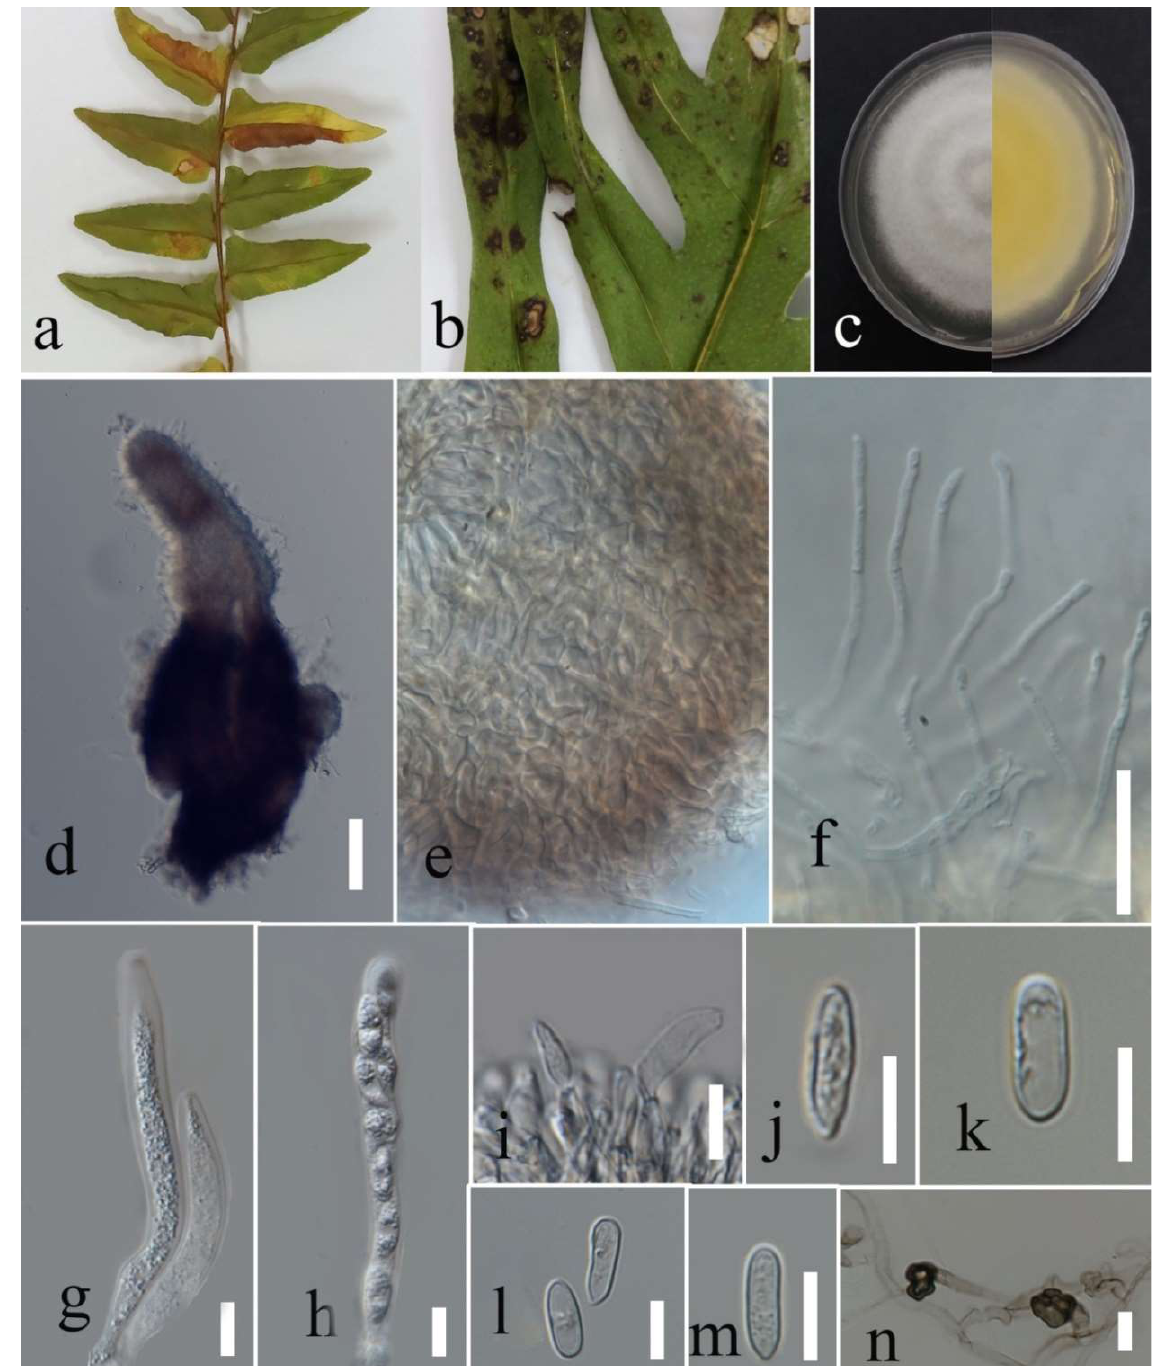
Figure 24. Morphology of Colletotrichum polypodialium ( ex-type : MFLUCC 22 - 0178 for asexual morph and culture; MFLU 22 - 0235 for sexual morph): ( a , b ) symptoms on Nephrolepis sp. and Phymatosorus sp.; ( c ) upper and reverse views of culture after seven days of growth on PDA at 28 °C; ( d ) perithecium; ( e ) peridium; ( f ) paraphyses; ( g ) immature asci; ( h ) mature ascus; ( i ) conidiogenous cells; ( j ) ascospore; ( k – m ) conidia; ( n ) appressoria . Scale bars ( d ) = 100 µm, ( f ) = 20 µm, and ( g – n ) = 10 µm .